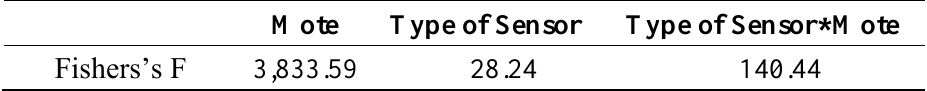
Table 2. ANOVA of spatial T data. Fishers‟s F for two factors (type of sensor and mote) and their interaction (confidence interval 95%).